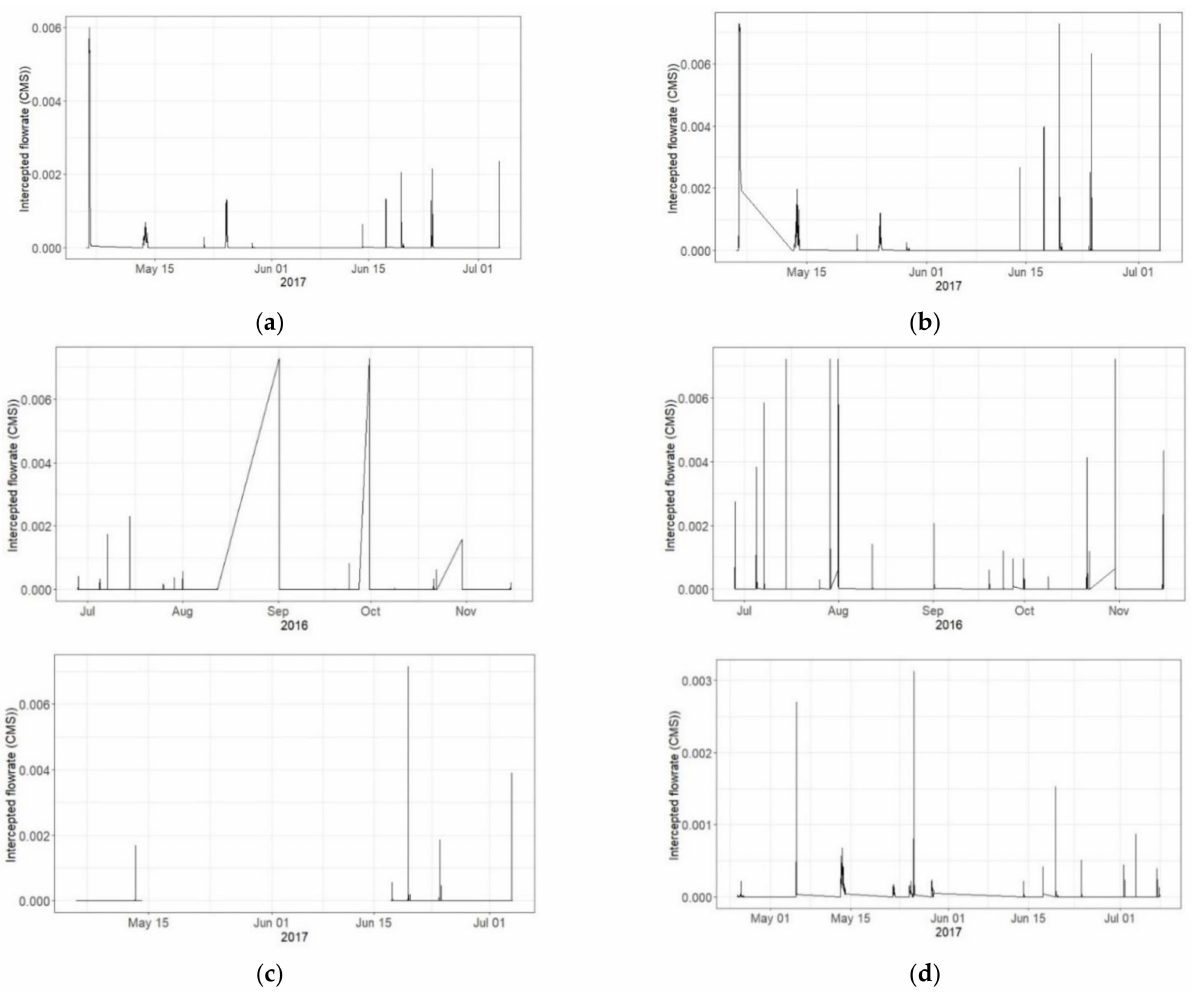
Figure A4. Intercepted flowrate for all inlets during monitoring period. ( a ) NW inlet ( b ) SW inlet ( c ) SE inlet ( d ) Nashville